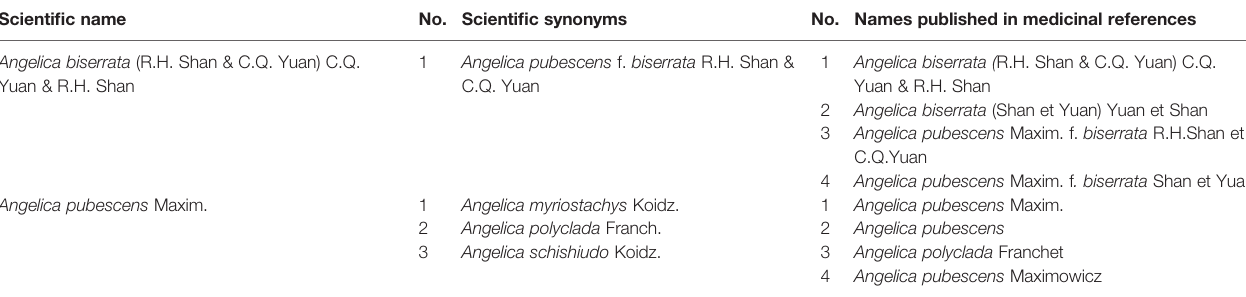
TABLE 2 | Scienti fi c synonyms and names published in medicinal references of medicinal plants as